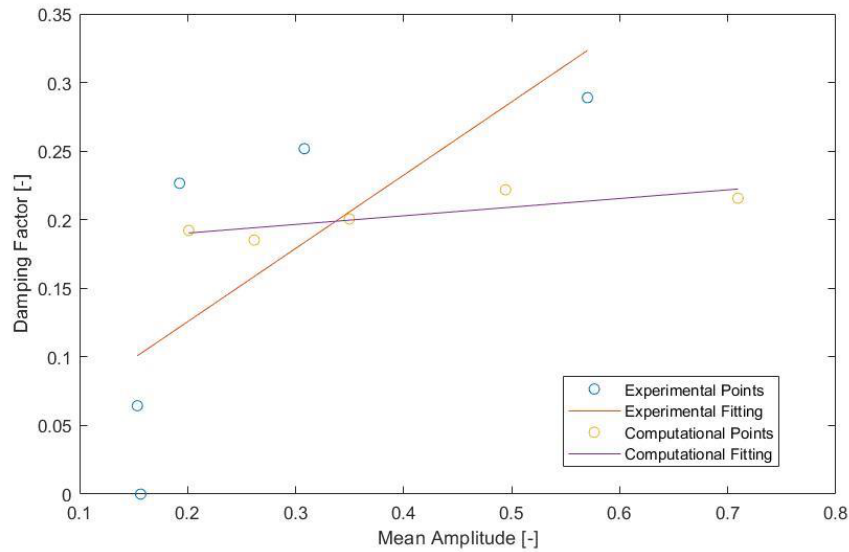
Figure 7. Damping factor study between the experimental and computational tests with linear fitting of both. Larger degree fittings were not studied due to the different DoFs used in both runs.